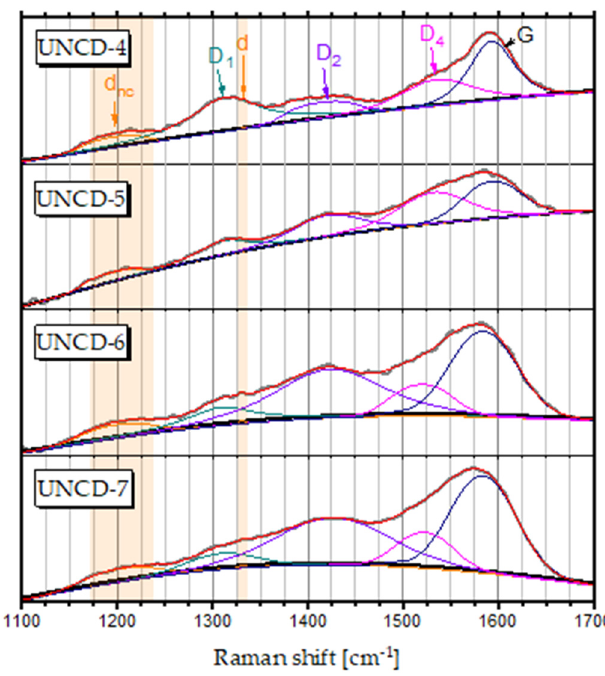
Figure 4. Raman spectra of the UNCD layers grown at methanol concentrations ranging from 4% to 7%. Various components derived from the peak fitting procedure are also depicted using the following colour code: orange for the diamond components (d and d nc components), dark cyan for the first C-H/ sp 3 defect-induced graphene component D 1 , violet and magenta for the D 2 and D 4 components, and black for graphene’s G-mode.